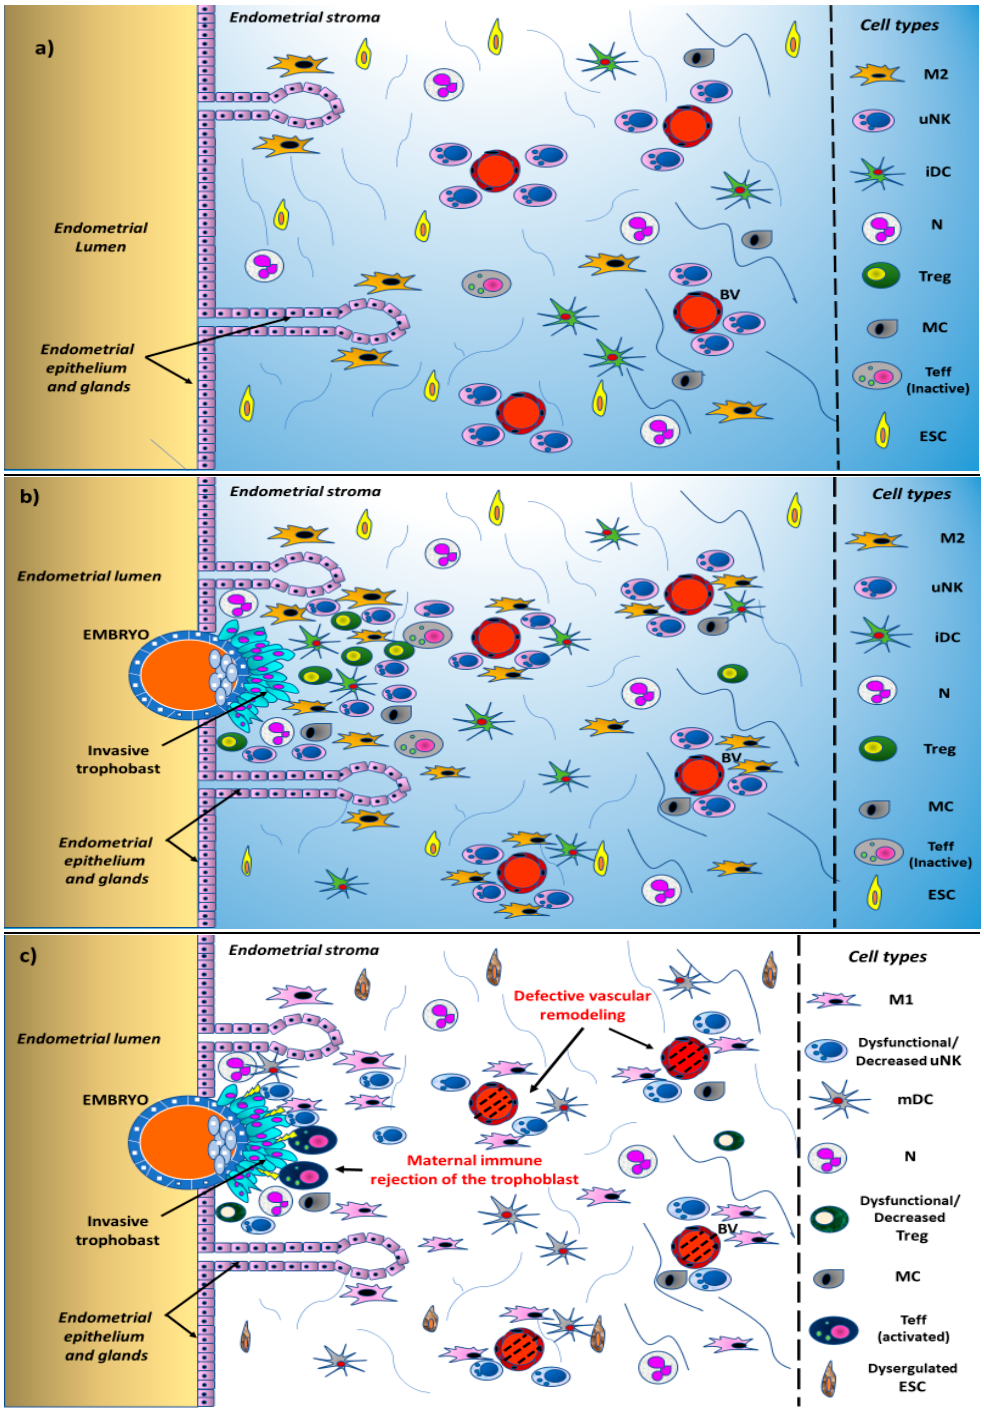
Figure 1. Schematic representation of the changes occurring in the human endometrium and in local immune cell trafficking in the normal state and in recurrent pregnancy loss (RPL). ( a ) Endometrium in the secretory phase of the menstrual cycle in the absence of the embryo; ( b ) endometrium in the presence of a normally implanting embryo; ( c ) endometrial immune derangements in RPL. M: macrophages; uNK: uterine natural killer cell; iDC: immature uterine dendritic cell; mDC: mature uterine dendritic cell; N: neutrophil granulocyte; Treg: regulatory T cell; MC: mastocyte; Te ff : e ff ector T cells; ESC: endometrial stromal cell; BV: blood